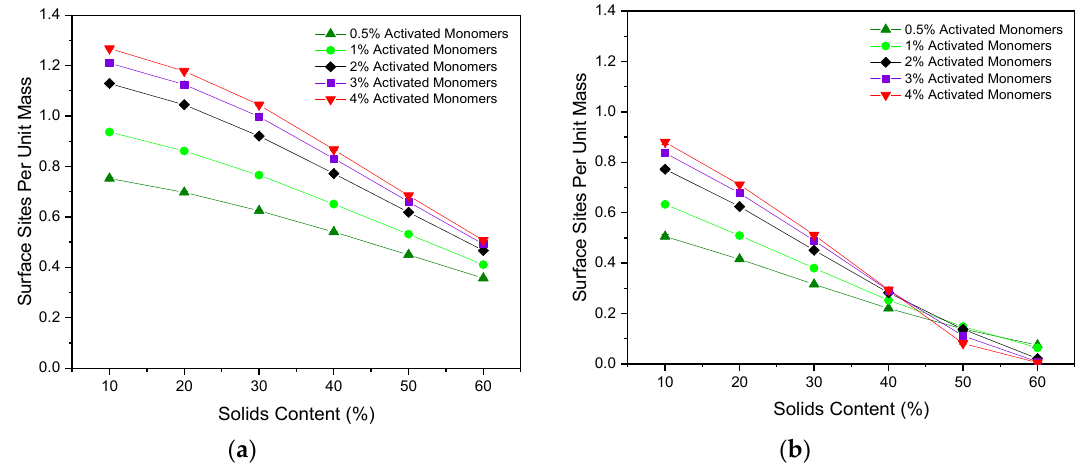
Figure 5. Accessible surface sites scaled with total mass with varying solids content ( S c ) and activated monomer ( C c ) values with respect to a di ff using particle of ( a ) Size 1 and ( b ) Size 3. Standard deviation error bars are present around each data point, although may not be visible due to their size relative to the data point marker.